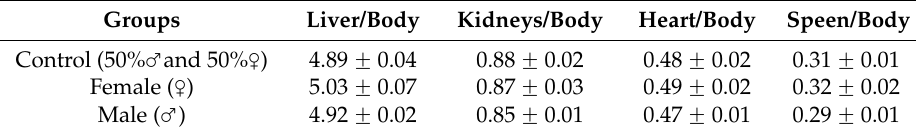
Table 2. Effects of GBP on ratio of organ to body weight in mice (x ˘ s, n = 10).